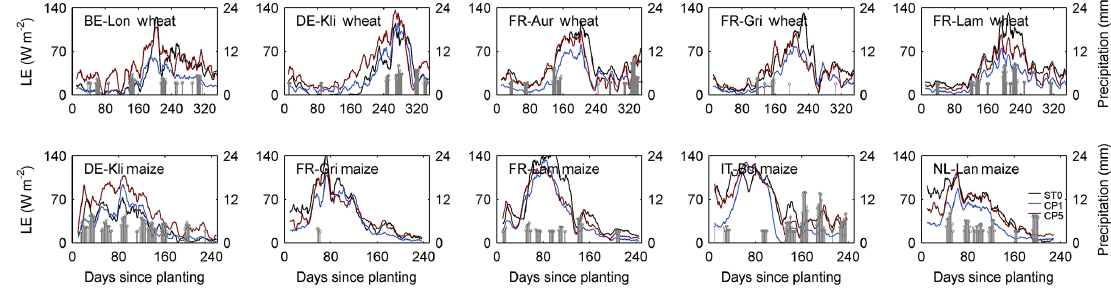
Figure 9. Same to Fig. 8 except for latent heat fluxes (LE).